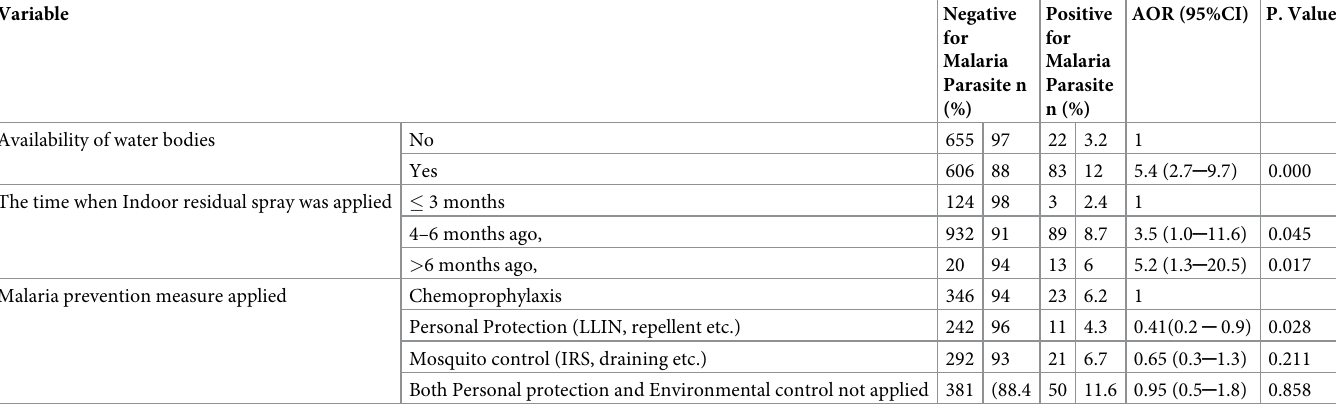
Table 3. Multivariable analysis of nurturing factors associated with asymptomatic malaria infection.